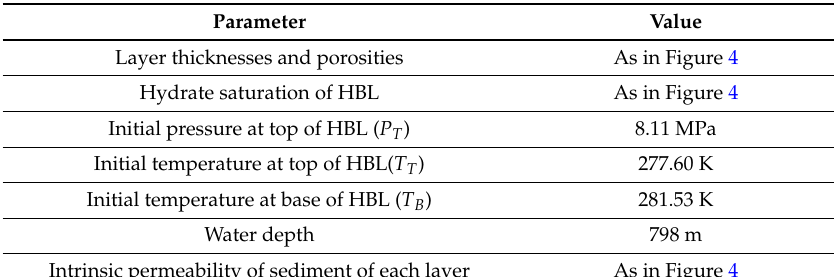
Table 1. Geophysical properties and simulation models in marine hydrate reservoir at Site GMGS2-8 of the Pearl River Mouth Basin.